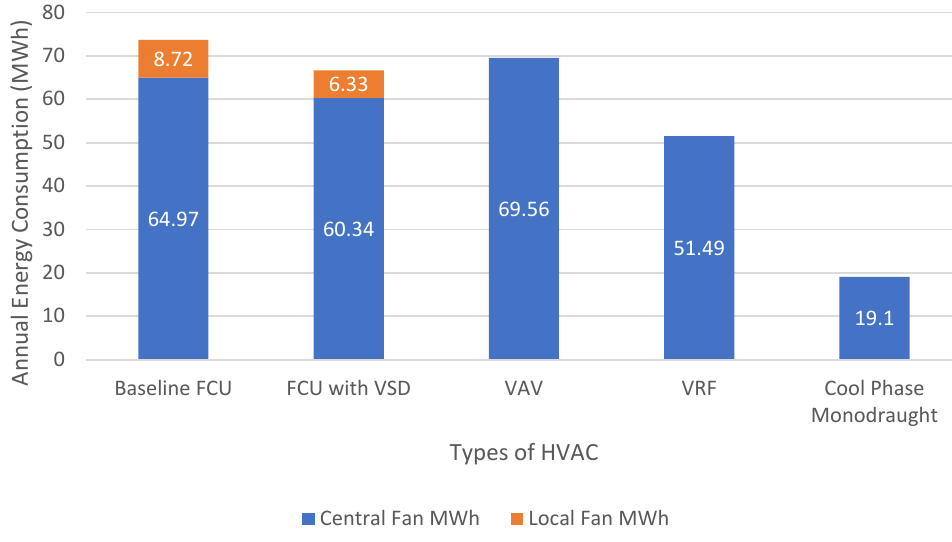
Figure 5. Annual energy consumption for the compared cooling systems.